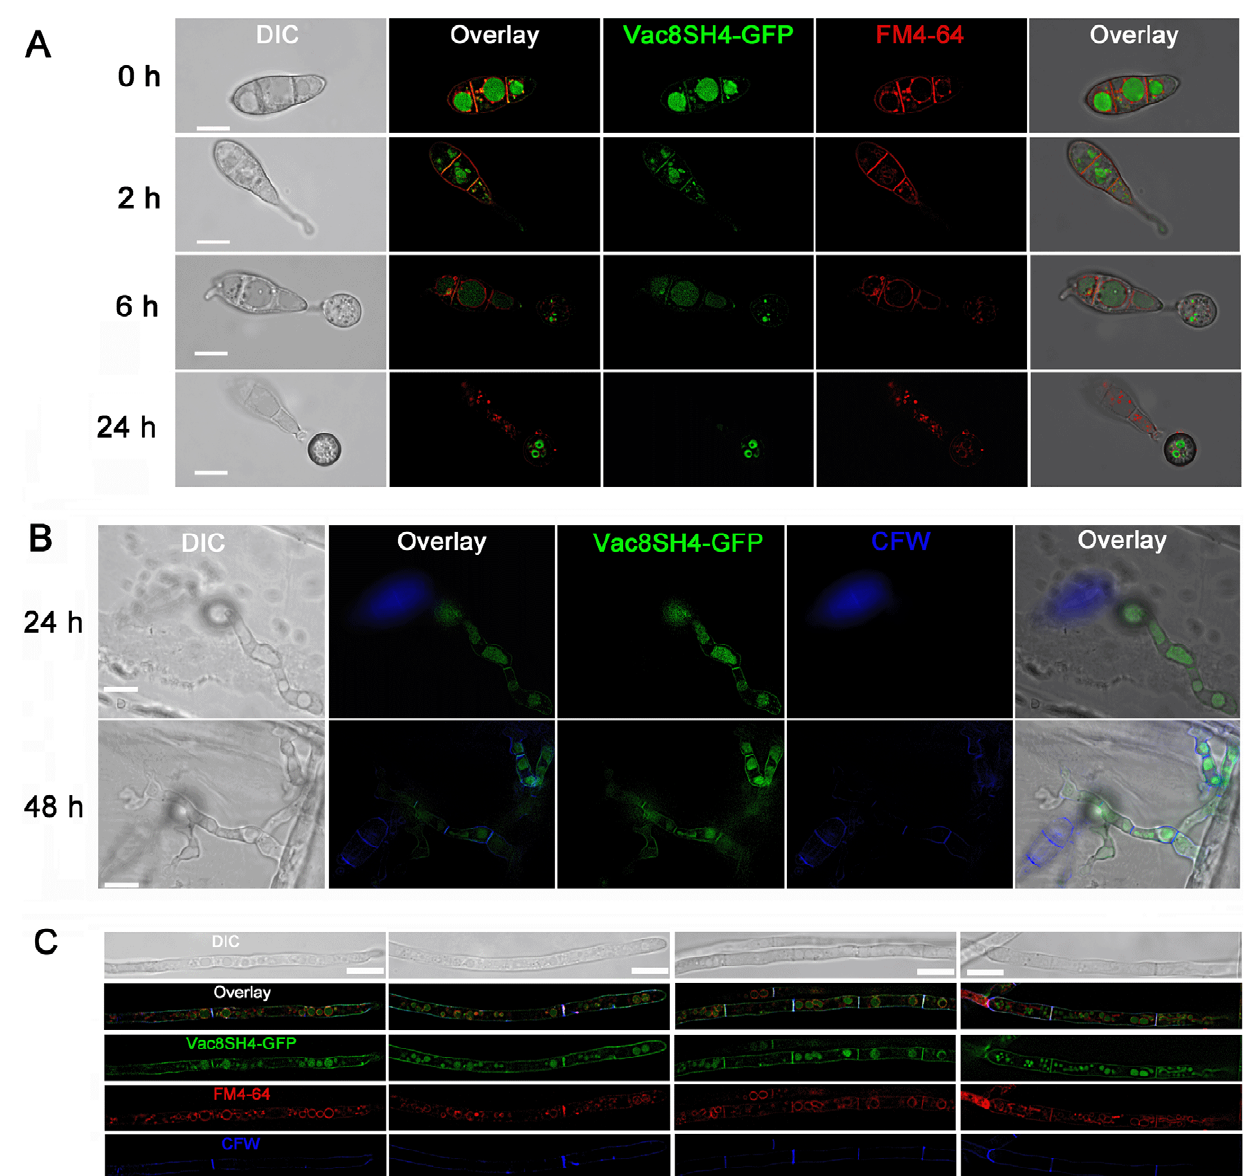
Figure 7. The N-terminus of MoVAC8p contains a SH4 domain. ( A ) SH4:GFP fusion proteins are anchored at the vacuole, septa and the plasma membrane in both conidia and appressoria. The first 21 amino acid residues of MoVAC8p were fused into the N-terminus of GFP to produce SH4:GFP and subcellular localisation of the GFP fusion analysed by epifluorescence microscopy. Guy11 conidia expressing SH4:GFP fusion proteins were stained with FM4–64 and allowed to germinate and undergo appressorium development. SH4:GFP fusions colocalise with the FM4–64-stained vacuole, septa and plasma membrane. ( B ) SH4:GFP fusion proteins associate with the vacuole, septa and the plasma membrane in penetration pegs and invasive hyphae. Penetration of onion epidermis was examined at indicated time points and Calcofluor White (CFW) used to stain the cell wall. SH4:GFP fusion proteins colocalise with the vacuole (as seen in the bright field image) and CFW-stained cell wall. ( C ) SH4:GFP fusion proteins were targeted to the vacuole, septa and the plasma membrane in vegetative hyphae. Vegetative hyphae expressing SH4:GFP fusion proteins were grown in CM for 24 h, and 200 m l of the cultures incubated with 7.5 m M FM4–64 at 26 u C for 1 h, followed by CFW staining. In vegetative hyphae, SH4:GFP fusion proteins also colocalise with FM4–64- stained vacuoles and CFW-stained septa and cell walls. Scale bar=10 m m.